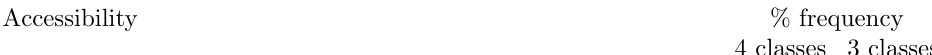
Table A.6: Frequency scores of the sub-sub factors of Accessibility